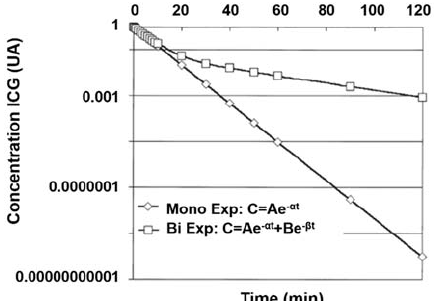
Figure 2. Mono ‐ as well as bi ‐ exponential models illustrating the decay of ICG concentration. C = Ae −α t is the mono ‐ exponential modelization, and C = Ae −α t + Be −β t is the bi ‐ exponential modelization for ICG blood clearance (C: concentration, A and B: constants, α , and β : slope of clearance, t: time). Reproduced from Ref. [31], with permission from Elsevier, 2000.